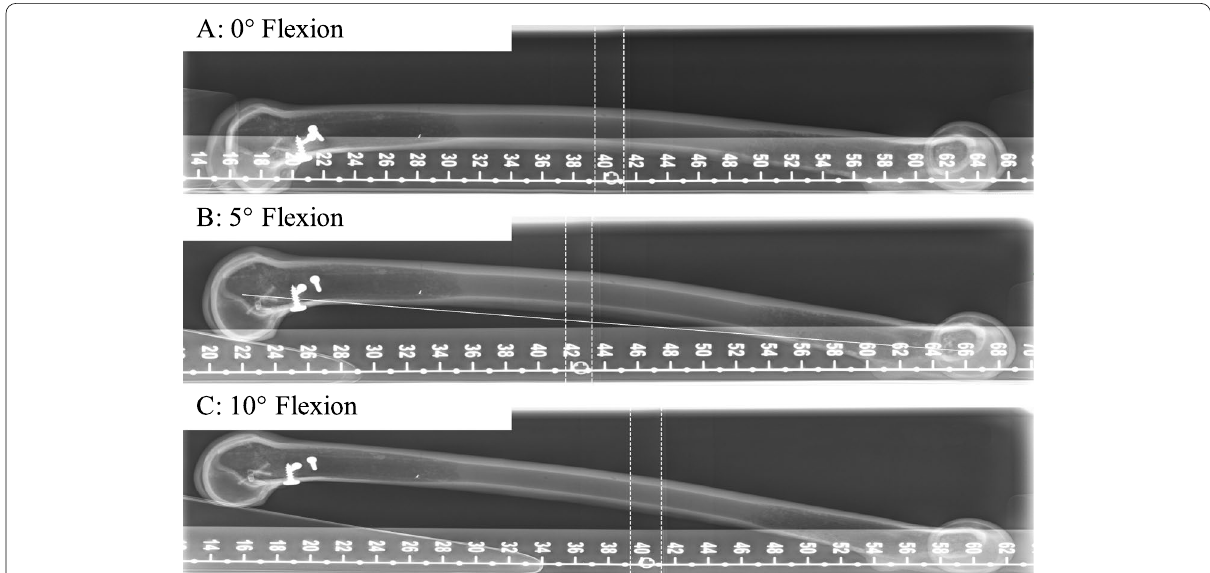
Fig. 2 Experimental setup of radiographic imaging for flexion error. Different flexion error setups with 0° flexion error ( a ), 5° flexion error ( b ) and 10° flexion error ( c ). Scale bar used for angle measurement and